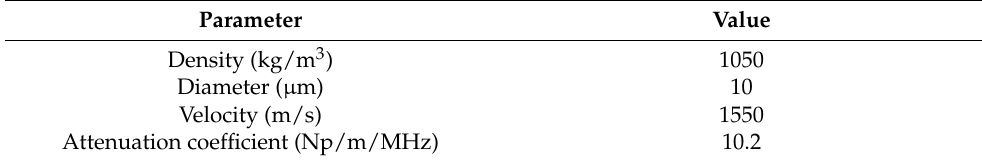
Table 1. Cell model and parameters in simulation.